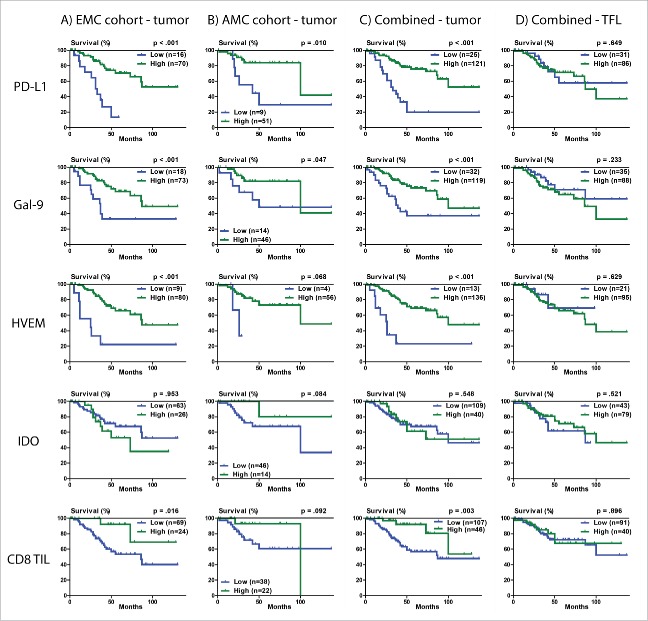
HCC-specific survival Kaplan-Meier curves of PD-L1, Gal-9, HVEM, IDO and CD8+TIL count in the tumor and TFL compartment. (A) Survival curves in relation to tumor expression for the discovery (EMC) cohort. (B) Survival curves in relation to tumor expression for the validation (AMC) cohort. (C) Survival curves in relation to tumor expression for the combined cohorts. (D) Survival curves in relation to TFL tissue expression for the combined cohorts. Optimal high vs. low values were established by examining a grid of cutoffs and choosing the cutoff with the lowest −2 log likelihood. For determination of the p values the Breslow test was used.